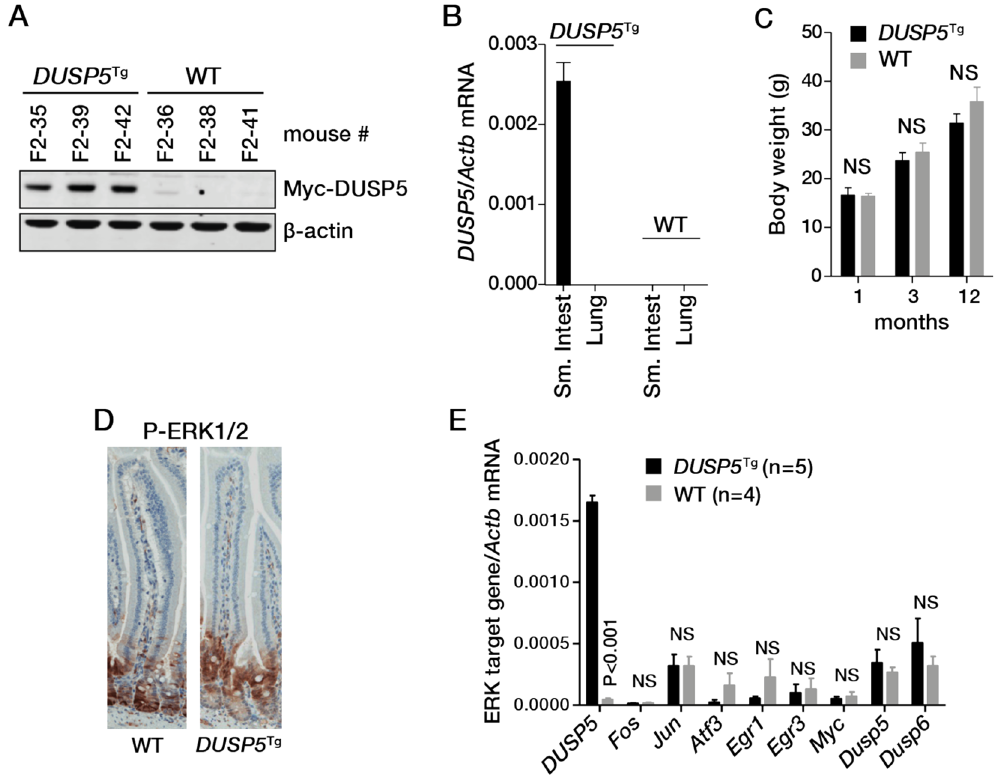
Figure 6. Impact of DUSP5 overexpression on ERK signaling in the mouse intestine. ( A ) Expression of human DUSP5 protein in the intestinal epithelium detected by blotting for the Myc-tag. ( B ) Expression of human DUSP5 mRNA specifically in the intestinal epithelium of transgenic mice. ( C ) Body weight of wild-type and Vil - DUSP5 Tg mice determined over time. Effects of DUSP5 overexpression on the ( D ) intensity and pattern of pERK1/2 staining and ( E ) expression ERK signalling-regulated genes in the intestinal epithelium. Three mice of each genotype were